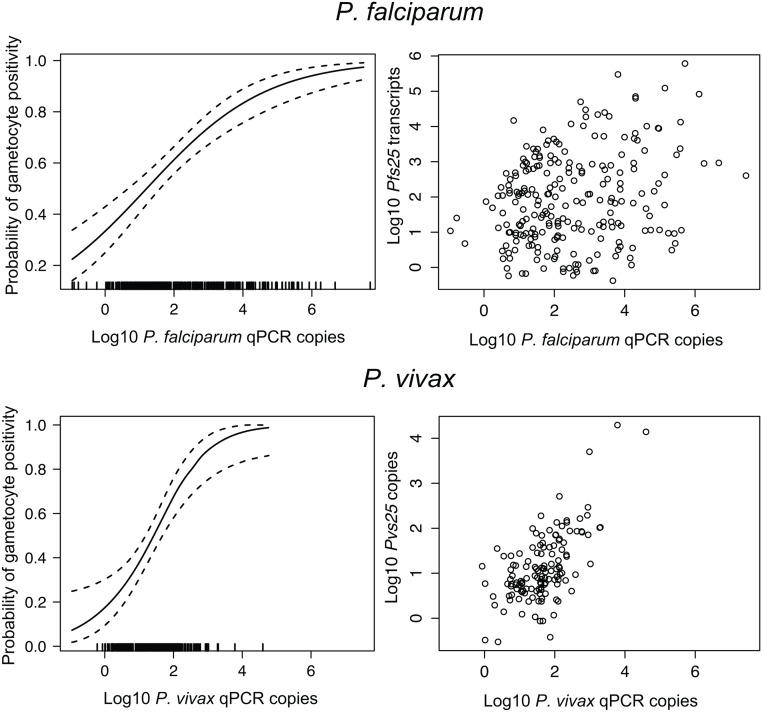

pvs25 transcript numbers versus light microscopically determined P. vivax gametocyte counts.Dilution series were made before storing samples in RNAprotect (5 dilution steps) or after RNA extraction of samples stored in TRIzol (3 dilution steps). Dots represent means of technical triplicates (TRIzol) or quintuplicates (RNAprotect) of dilutions except for the highest concentration (no replicates). Shaded grey shows the CI95 of the intercept of the regression of compiled sample sets.